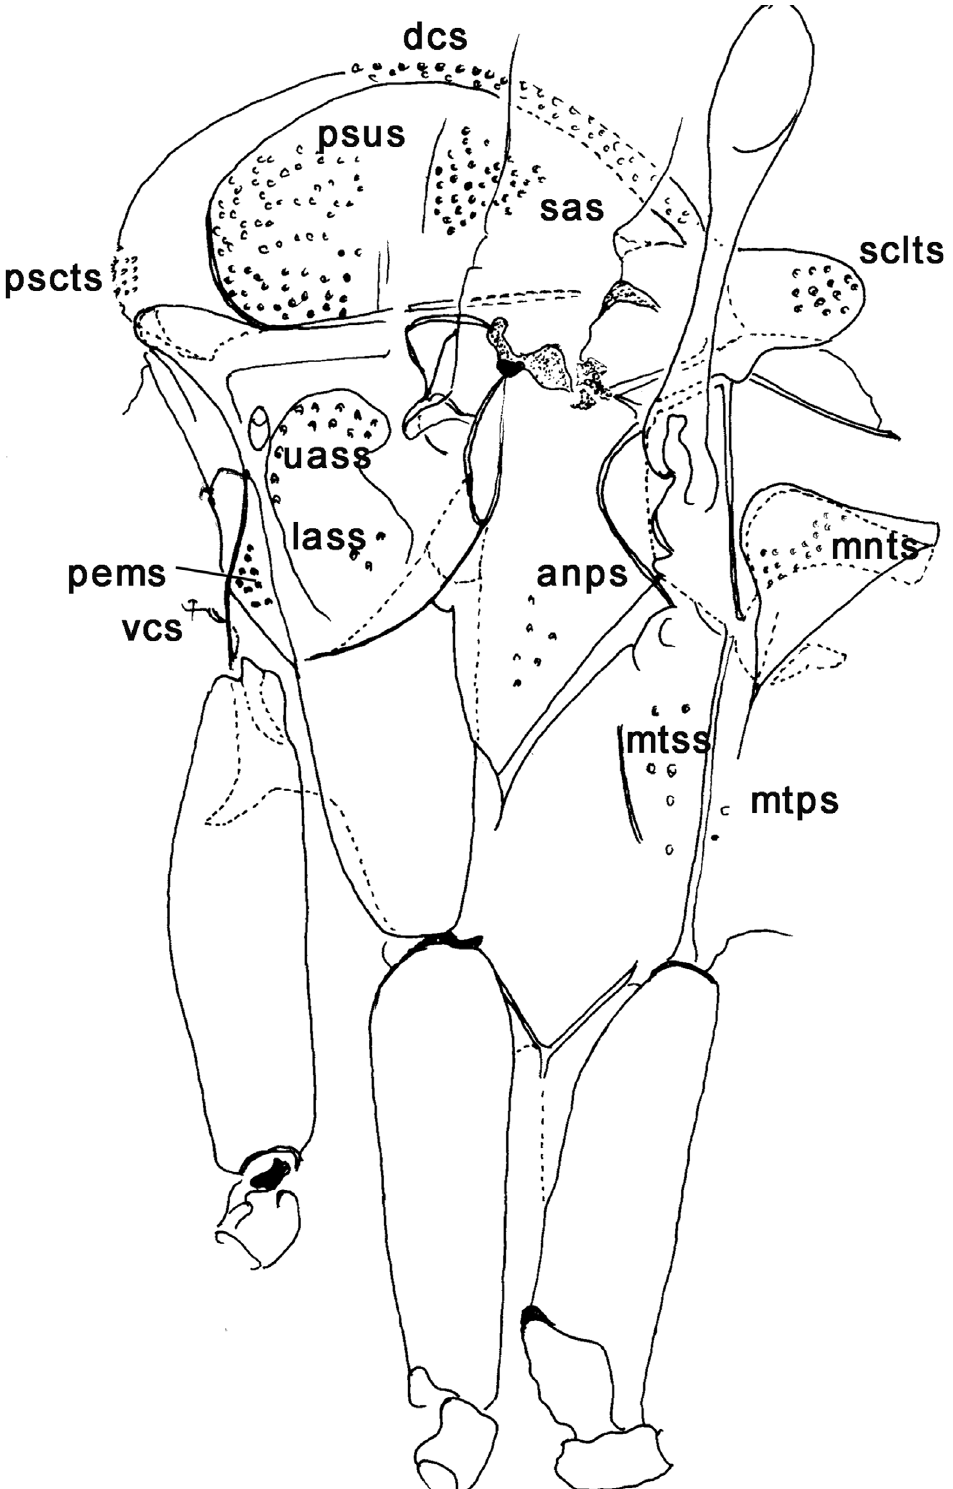
Figure 11. Setae on the thorax of phlebotomines: anps – anepimeral setae; dcs – dorsocentral setae; lass – lower anepisternal setae; mnts – metanotal setae; mtps – metepimeral setae; mtss – metepsiternal setae; pems – proepimeral setae; pscts – prescutal setae; psus – postsutural setae; sas – supralar setae; sctls – scutelar setae; uass – upper anepisternal setae; vcs – ventrocervical sensilla. Brumptomyia pintoi